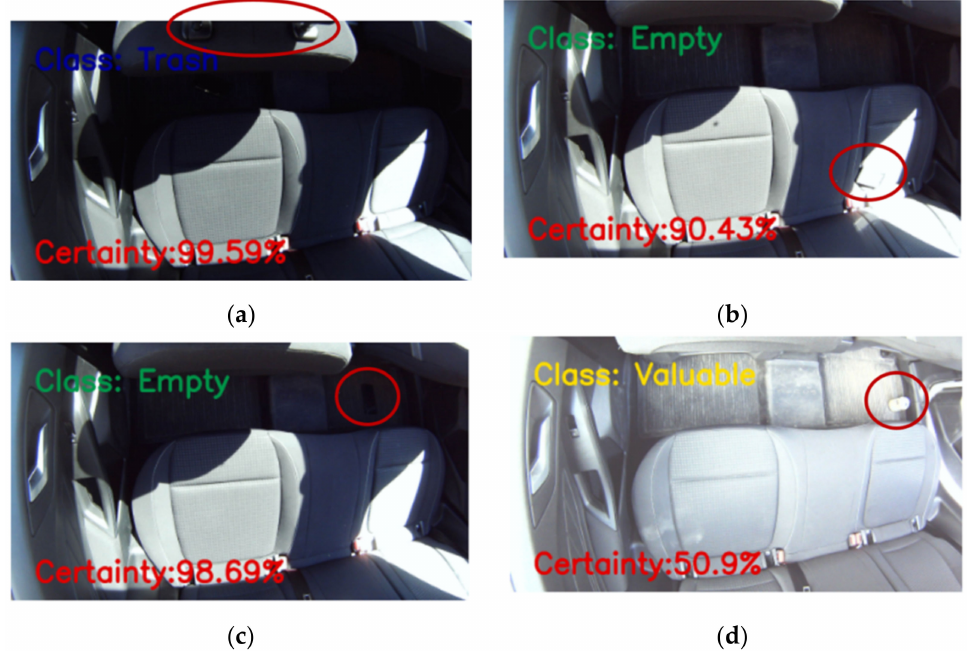
Figure 11. Samples of misclassified images with red circles corresponding to ( a ) base of the driver’s head rest, ( b ) item subjected to glare, ( c ) item lacking contrast with the neighbourhood and ( d ) item with lack of contrast at one of the furthest points from the